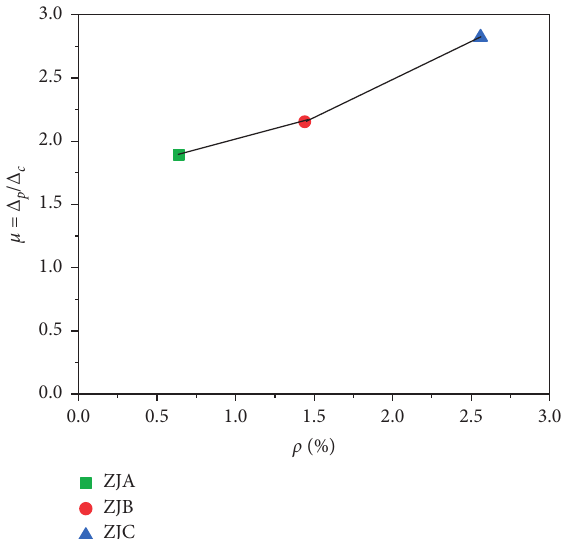
Figure 12: Bamboo reinforcement ratio and ductility index curves.